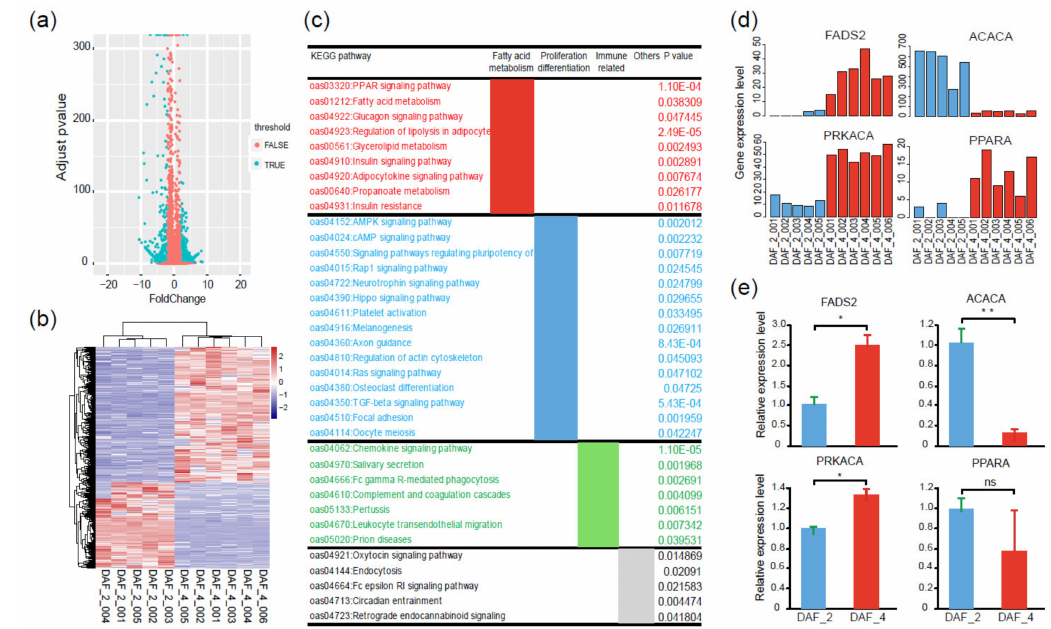
Figure 5. Di ff erent gene expression profiles between Fat-1 transgenic 100-day fetuses and postnatal lambs. ( a ) Volcano plot of 1447 DEGs between Fat-1 transgenic 100-day fetuses (DAF_2) and postnatal lambs (DAF_4). ( b ) Heatmap showing di ff erent transcription levels of DEGs between DAF_2 and DAF_4; the pink color represents a higher expression level, and the blue color represents a lower expression level. ( c ) KEGG pathway analysis of the DEGs between DAF_2 and DAF_4. ( d ) Comparison of four key node gene expression levels between DAF_2 and DAF_4 according to transcriptome data. ( e ) Gene expression validation of four key node genes by qPCR ( t -test, ** p < 0.01, * p < 0.05, ns p > 0.05).